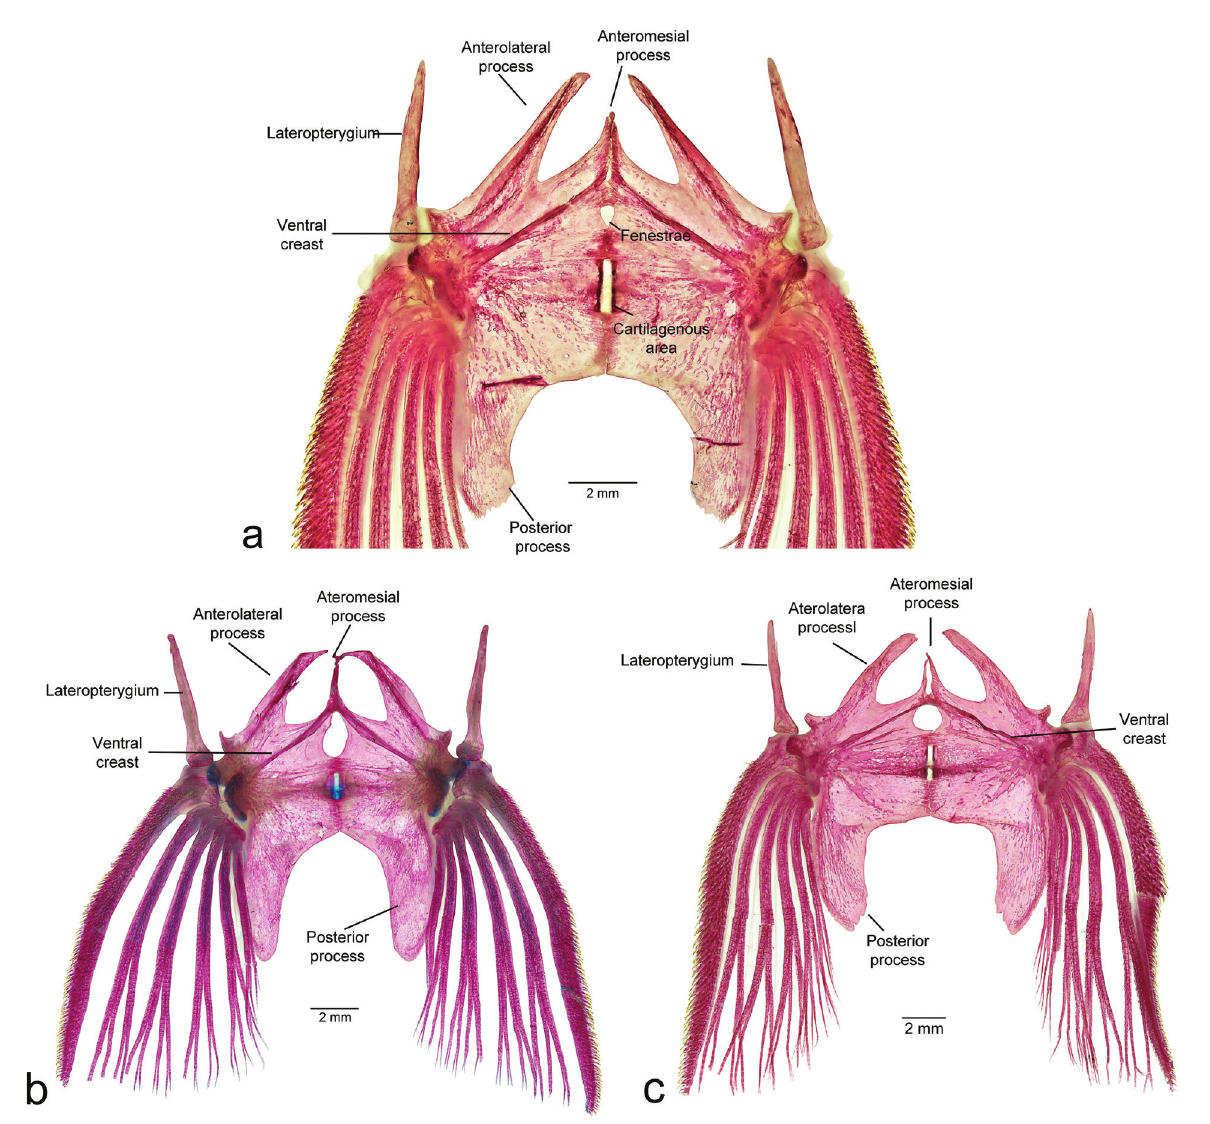
Fig. 11. Basipterygia and pelvic fin of (a) Spectracanthicus murinus , MZUSP 24293, 37.0 mm SL; (b) S. immaculatus , paratype, MZUSP 92617; 58.9 mm SL and (c) S . tocantinensis , paratype, MZUSP 34265, 65.4 mm SL. Scale bars = 2 mm. Image by E.